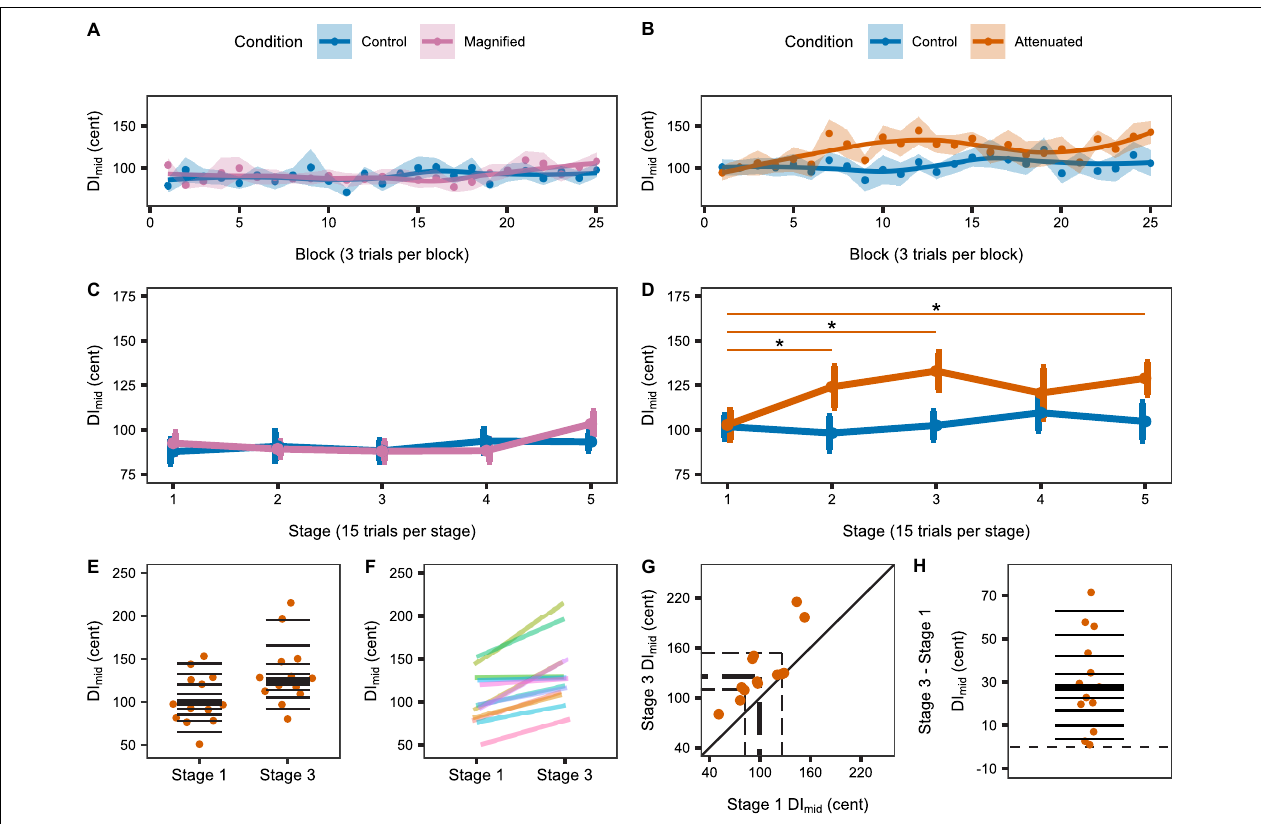
FIGURE 5 | (A,B) Change in DI mid across the Variability task by block (i.e., 3 trials) for the Magnified and Attenuated feedback variability conditions. Dots represent the group mean DI per block. Shaded regions indicate standard error of the mean (SEM). Solid lines are loess smoothed fits (span = 0.6). (C,D) Change in DI mid across the Variability task by stage (i.e., 15 trials) for the Magnified and Attenuated feedback variability conditions. Error bars indicate SEM. Asterisks indicate adjusted p < 0.05 (see Table 1 ). (E–H) Individual participant data for the significant change from Stage 1 to Stage 3 in the Attenuated condition: (E) Stripchart of DI mid in Stage 1 and Stage 3. Horizontal lines indicate deciles; bold line is the median. (F) Stripchart with each participant’s Stage 1 and Stage 3 data linked. (G) Scatterplot of Stage 1 by Stage 3 data. The diagonal line denotes no difference between stages. Participants in the upper left half increased DI mid in Stage 3. Dashed lines mark quartiles. (H) Stripchart of the difference in DI mid between Stage 3 and Stage 1. Horizontal lines indicate deciles; the bold line is the median; the dashed line is at zero (no difference between